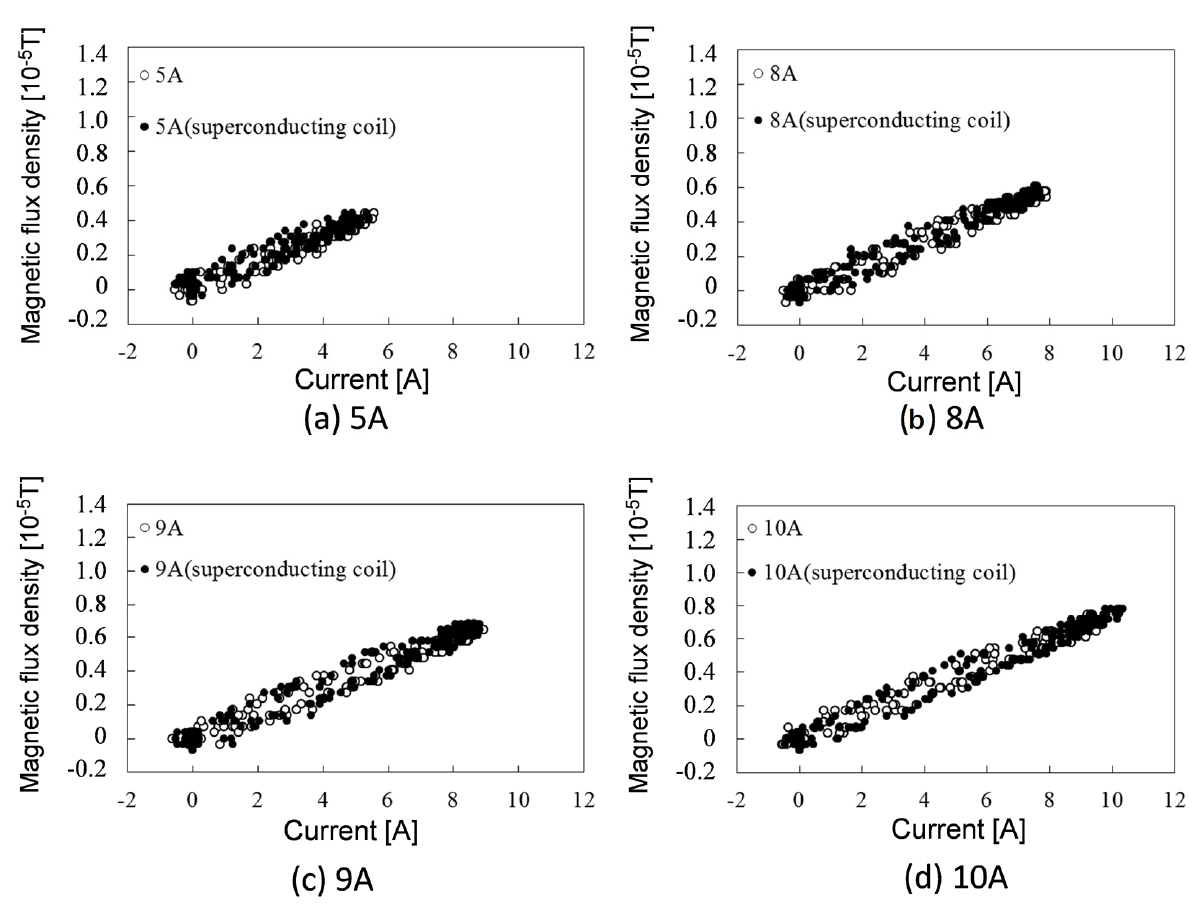
(Figure 8a), the magnetic flux density without the superconducting coil (white circles) and the magnetic flux density with the superconducting coil (black circles) are plotted in the same area. The same phenomenon in Figure 8b–d is observed as in Figure 8a. This means that there is no mutual interaction between a superconducting coil and one copper coil.